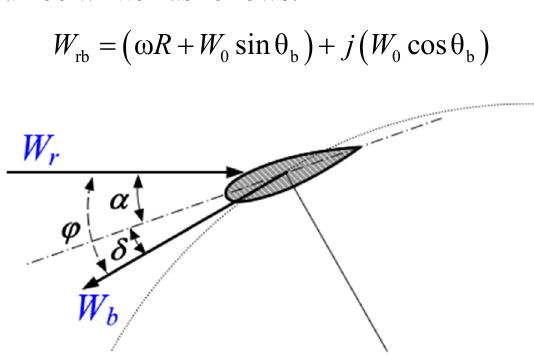
Figure 4. Definition of angles and